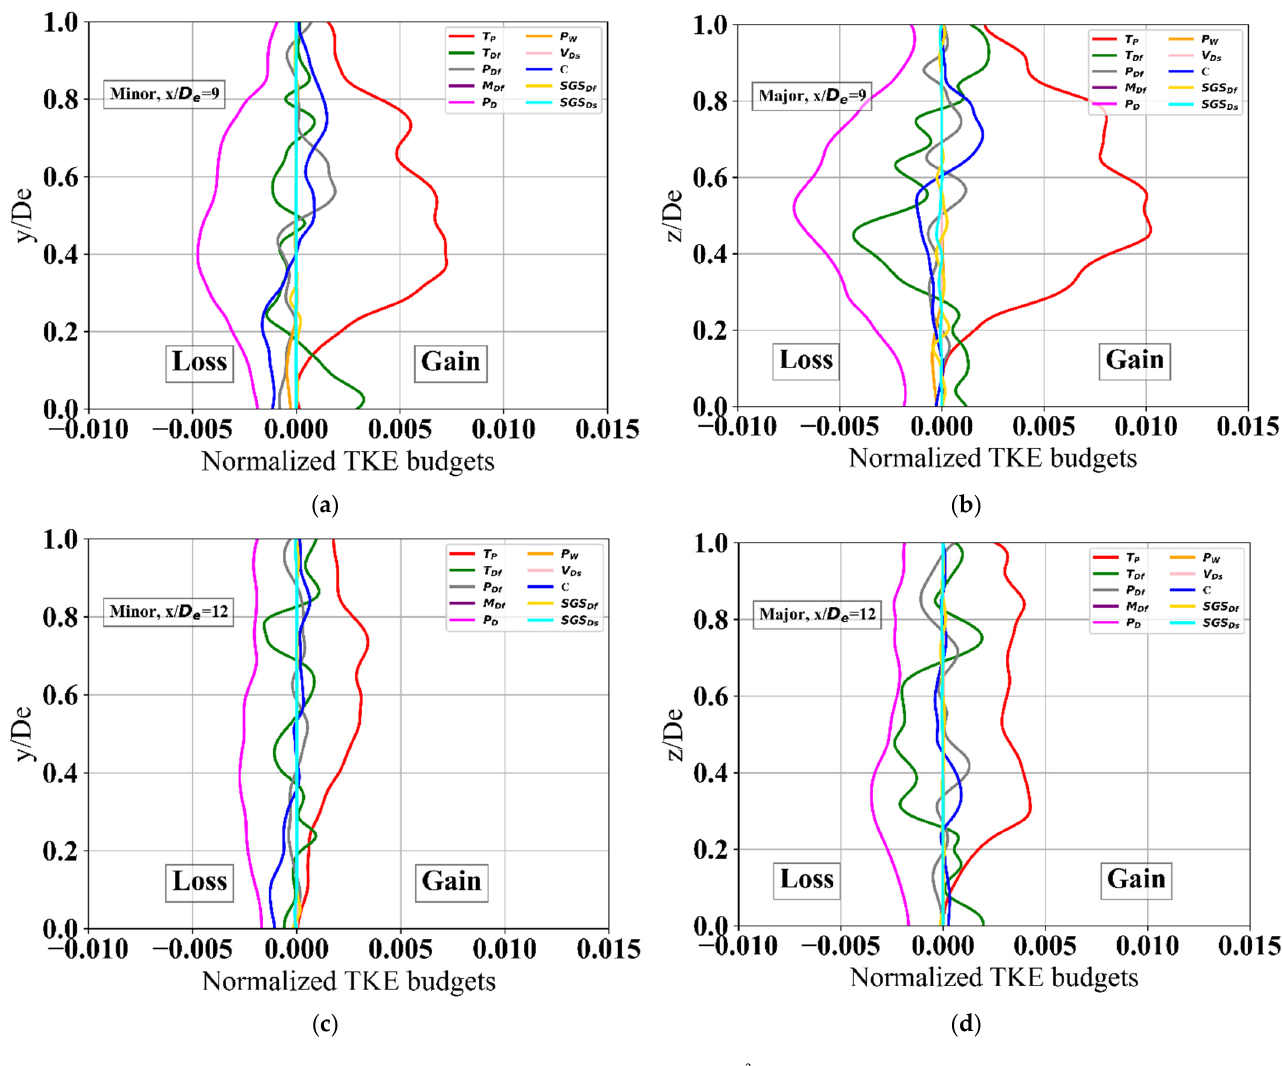
Figure 10. TKE budgets (normalized by major axis, ( c ) x/De = 12—minor axis, ( d ) x/De = 12—major axis.